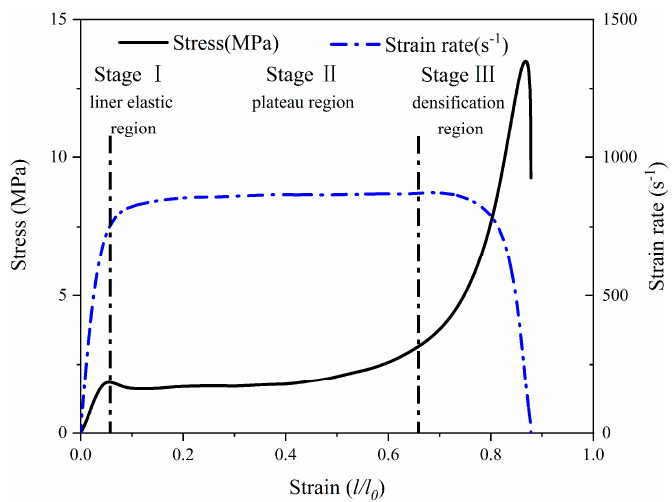
Figure 6. A representative set of stress–strain and strain rate–strain graphs of the H75 PVC foam test at 863.7 s − 1.